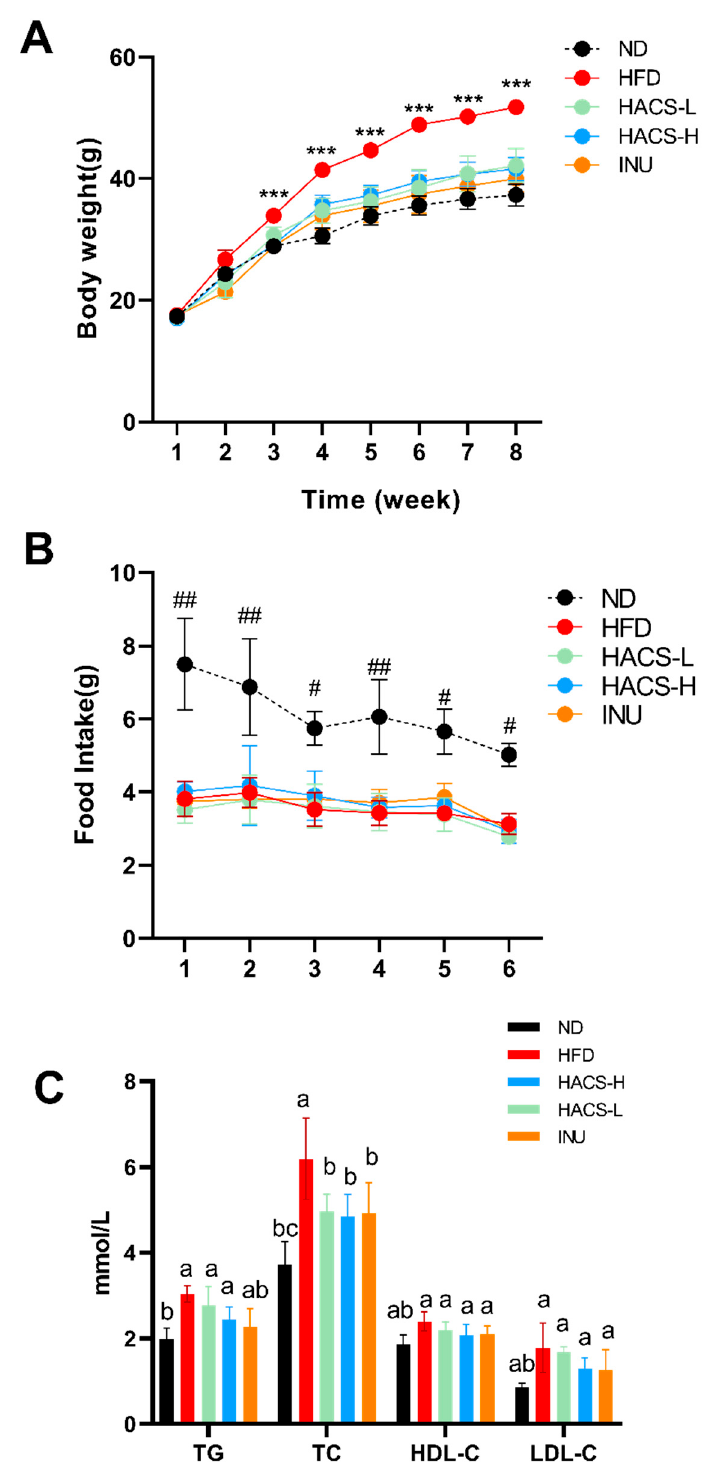
Figure 1. Effects of HACS treatment on the body weight ( A ), food intake ( B ), and blood lipid levels ( C ) of ICR mice. ICR mice were fed each diet for 7 weeks: ND, normal diet; HFD, high fat diet; HACS-L, high fat diet + 0.25 g/kg HACS; HACS-H, high fat diet + 0.5 g/kg HACS; INU, high fat diet + 0.5 g/kg inulin. Data were expressed as the mean ± SD ( n = 5 per group). *** p < 0.001 vs. ND, INU, HACS-L and HACS-H ( A ); # p < 0.05 and ## p < 0.01 vs. HFD ( B ); different lowercase letters represent significant differences ( p < 0.05), and the same lowercase letters represent no significant differences ( p ≥ 0.05) ( C ).